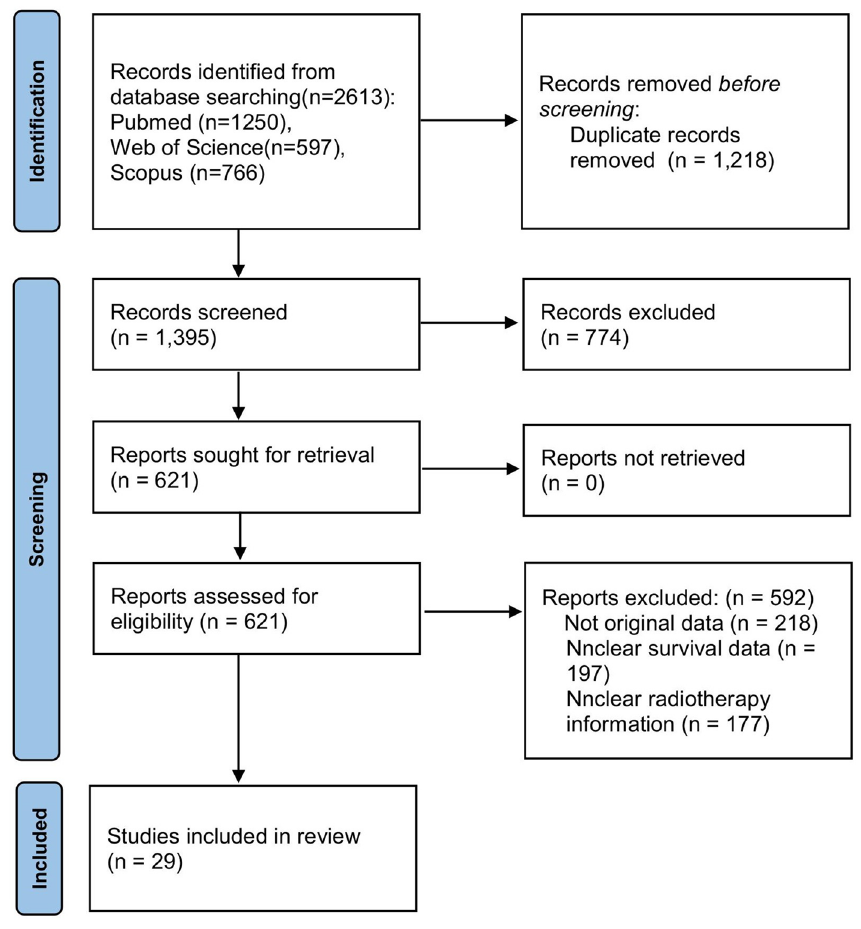
Figure 1. PRISMA flowchart of the process for study